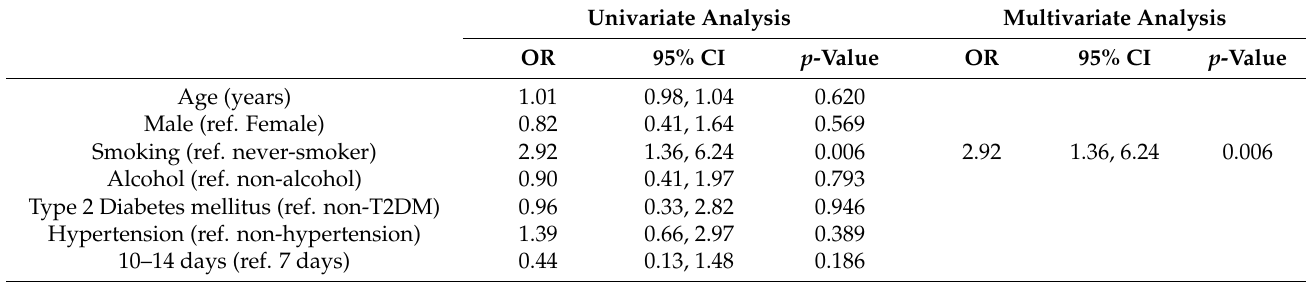
Table 3. Logistic regression analysis to predict factors for eradication rate. (Per-Protocol).